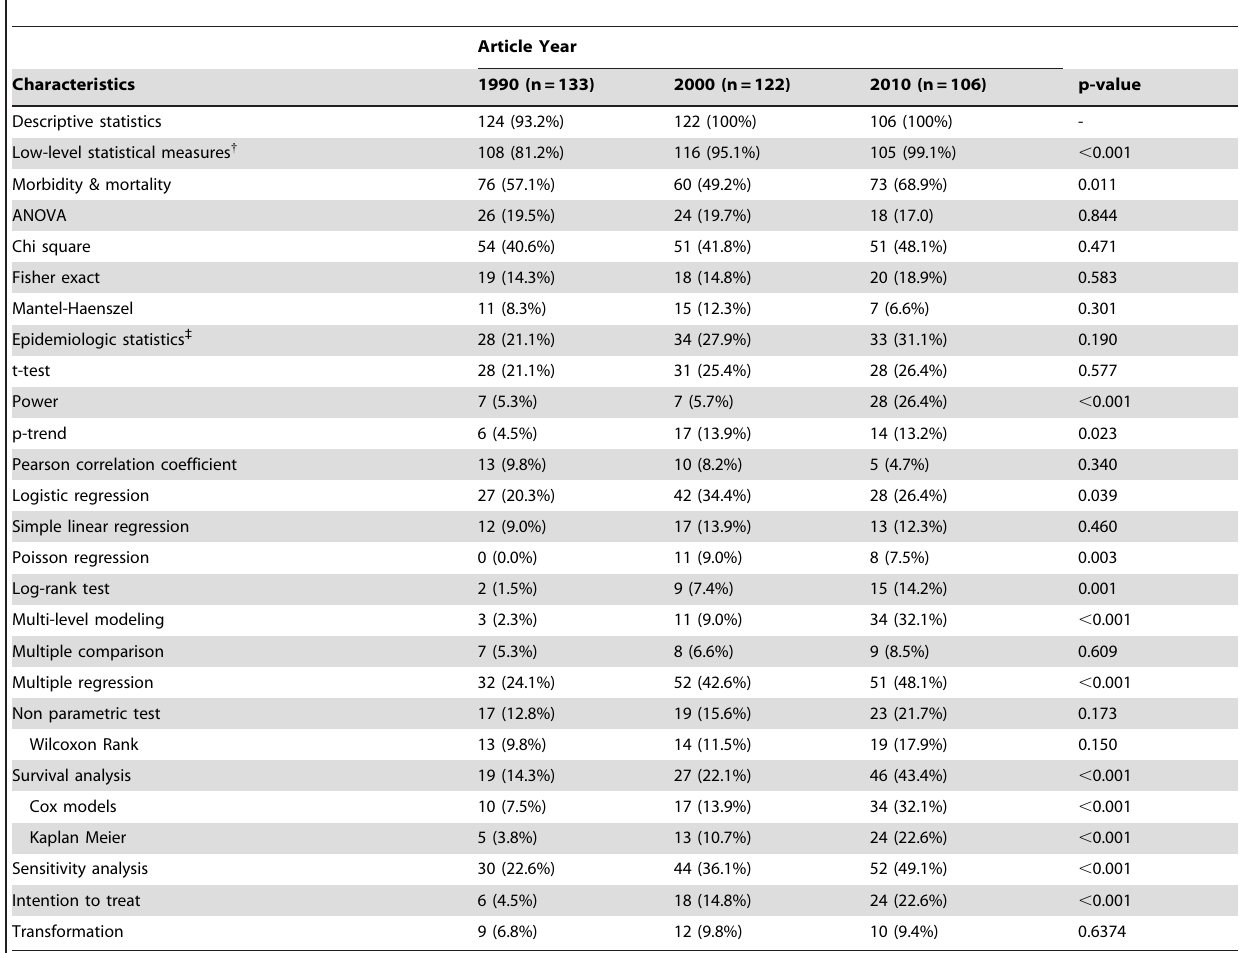
Table 3. Statistical measures and methods in JAMA articles published in 1990, 2000, and